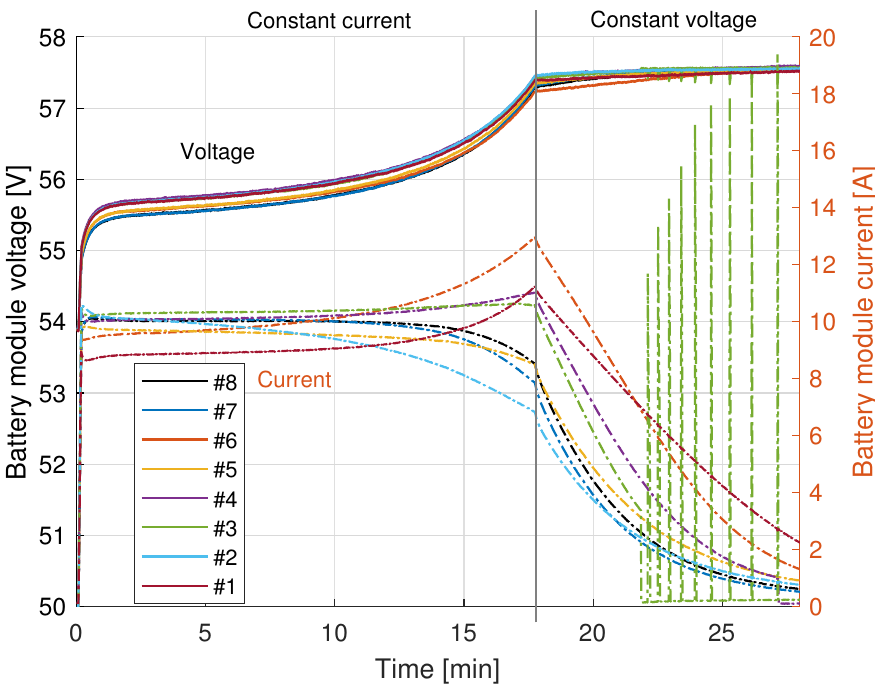
Figure 6. Parallel charging of battery pack in 48V configuration, as used in regenerative braking. In first phase, total charging current is limited, while in second phase the pack’s charging voltage is limited. Green peaks at right-side indicate that module #3 is close to full charge and its battery management system (BMS) went into trickle charging mode. At end of sequence, also module #4 went into trickle charging